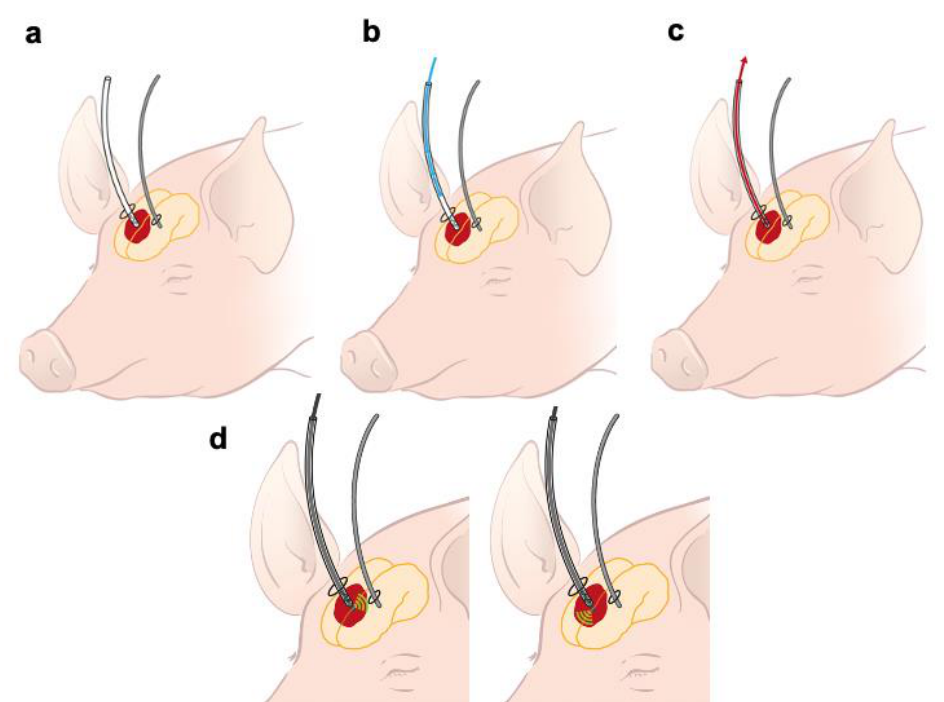
Figure 1. ( a ) This image shows a schematic illustration of a pig with an intrahematomal (red) catheter (white) in the right frontal area and an intracranial pressure (ICP) probe (grey) in the left frontal area; ( b ) Lysis-catheter inside the hematoma, the blue arrow illustrates the application of 1 mg rtPA after the initial MRI. ( c ) After treatment, the intrahematomal catheter was connected to a gravity-based drainage system for one hour (red arrow). Afterwards, an MRI of the brain was repeated. ( d ) Intrahematomal catheter after the first MRI. Inside the lumen of the lysis-catheter there is the ultrasound-catheter (black), absorbing ultrasound, cone-shaped laterally (green waves) for 30 min in each direction. After this time, it is turned 180° to the other direction (right image).